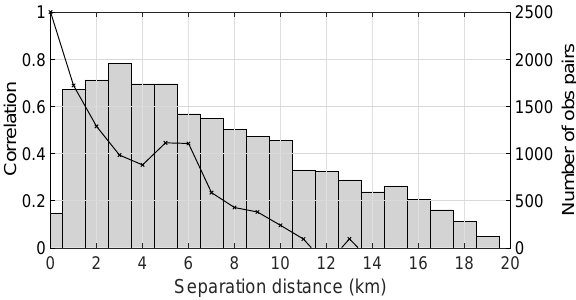
Figure 4. Estimated SAR WLO error correlations (black line) and number of samples (bars) used (bin width = 1km), east domain. Es- timated error standard deviation is 43cm.